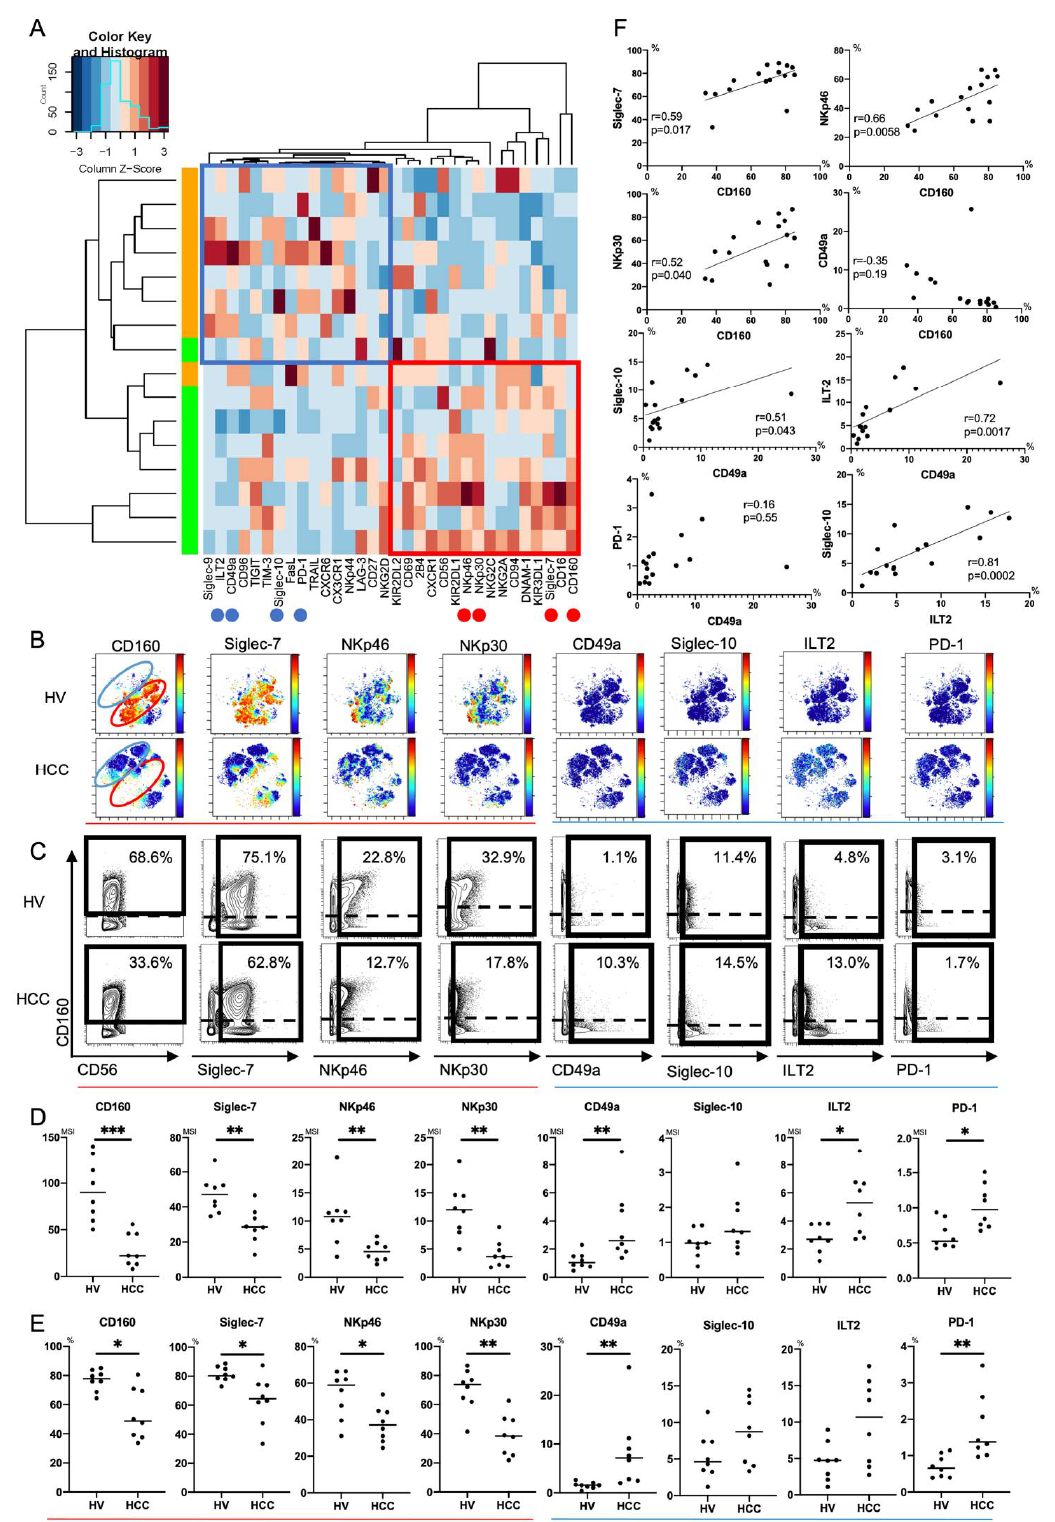
Figure 2. Phenotypic characterization of peripheral CD56 dim NK cells from HCC patients. ( A ) Heatmap and hierarchical clustering of the surface marker expression on CD56 dim NK cells (CD45 + CD3 - CD14 - CD19 - CD56 dim ) from HCC patients and healthy volunteers (HVs). Each expression level was scaled through samples and z scores were used for the color scale. The horizontal axis represents 32 surface markers on CD56 dim NK cells. The vertical axis represents samples of HCC patients and HVs. The heatmap indicates the deviation score of expression levels of surface markers in any sample.